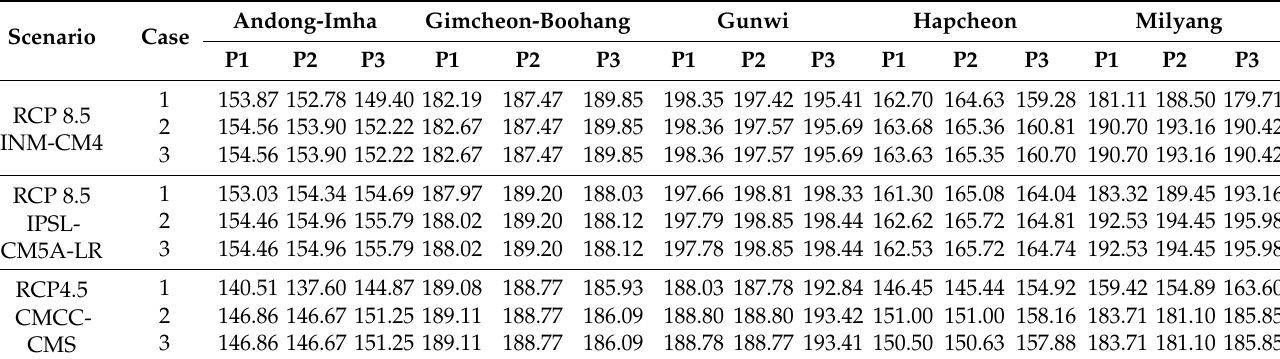
Figure 6. Comparison of the Gunwi reservoir’s water level for Case 1, 2, and 3 in three climate change scenarios from 2011 to 2100. These three climate change scenarios are RCP 8.5 INM-CM4 ( a ), RCP 8.5 IPSL-CM5A-LR ( b ), and RCP 4.5 CMCC-CMS ( c ). The dotted black box highlights the extreme drought period (from 2070 to 2080). Table 6. Comparison of average low water level (m) for Case 1, 2, and 3 for five reservoirs.